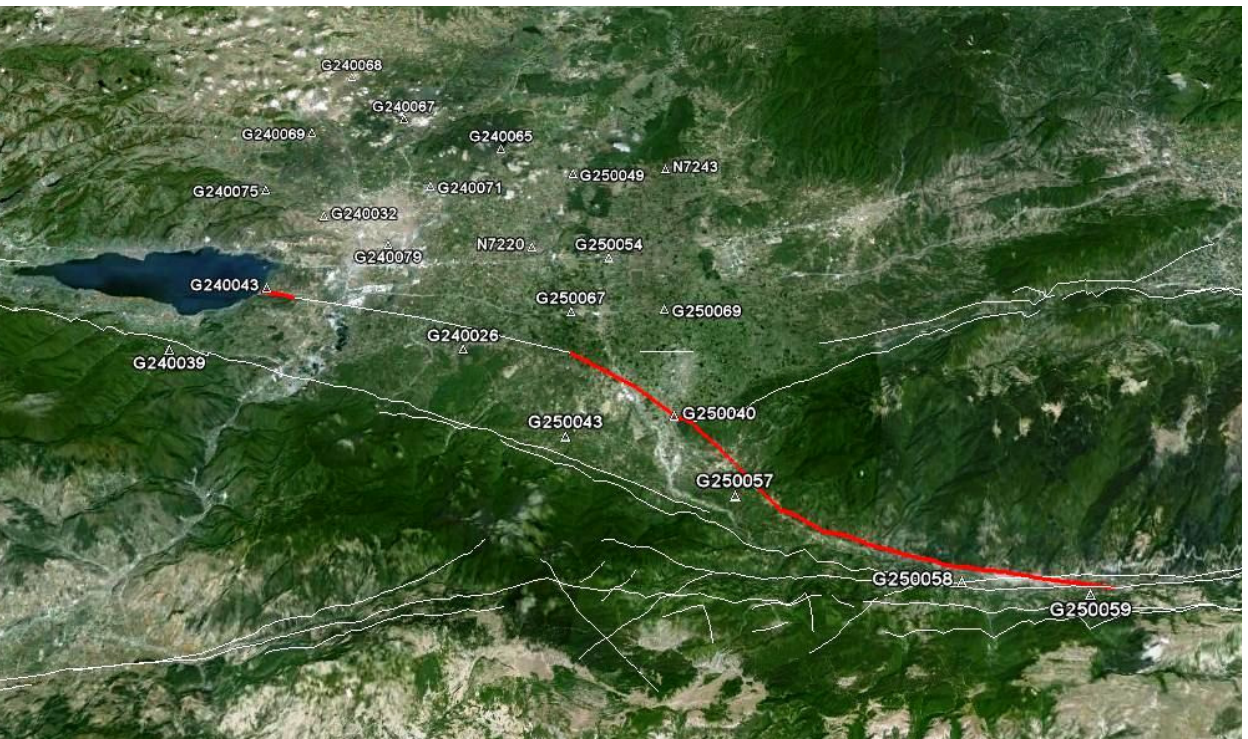
Fig. 7. Surface rupture in the Sakarya region. The red line shows the surface rupture defined by this study (satellite image from Google